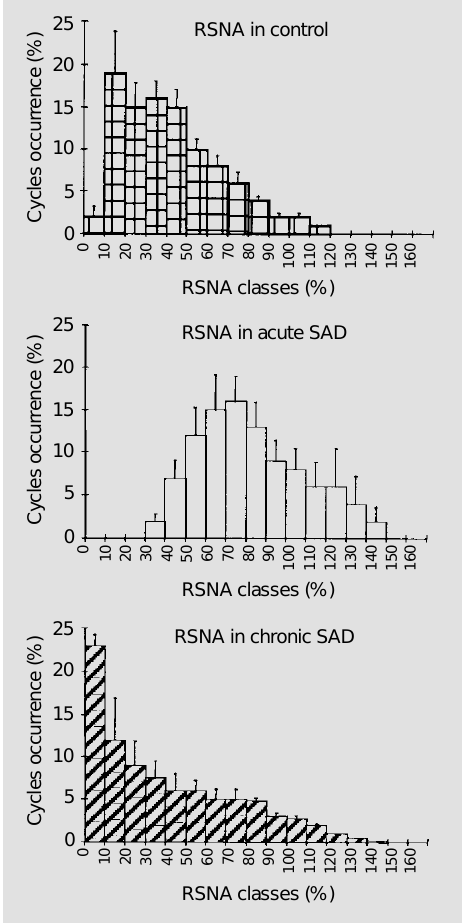
Figure 1 - Bar graphs showing the occurrence of cardiac cycles at each level of normalized renal sympathetic nerve activity (RSNA) in control (top), acute (middle) and chronic sinoaortic denervation (SAD) (bottom). Ob- serve the different proportions of cardiac cycles from 0 to 40% (from Ref.